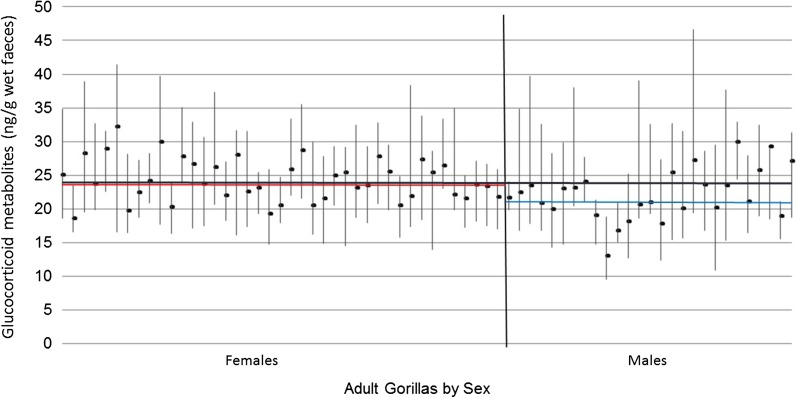
Adult male mountain gorillas (n = 28) had lower mean baseline faecal glucocorticoid metabolite concentrations than adult females (n = 44; F = 13.20, P < 0.001, n = 1936 faecal samples). Individual points represent the mean ± 1.5 SD for each animal; the vertical black lines are the upper and lower 95% confidence intervals. The blue line represents the mean of the mean ± 1.5 SD for all adult males; the red line represents the mean of the mean ± 1.5 SD for all adult females.